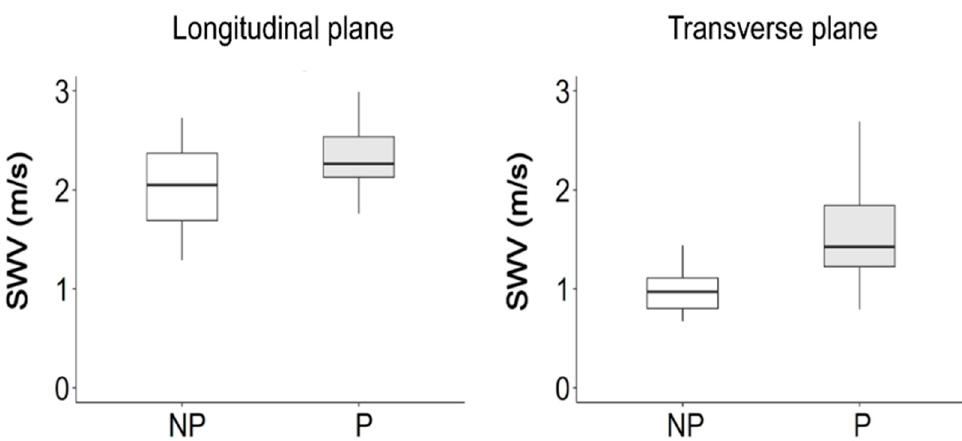
Figure 3. Box-and-whisker plots of shear wave velocity (SWV). The results reveal differences in SWV of the biceps brachii muscle (BBM) between the paretic (P) and non-paretic (NP) arm in the longitudinal and transverse planes. All SWVs of P BBM were significantly higher than of NP BBM in both planes (all p values < 0.001).